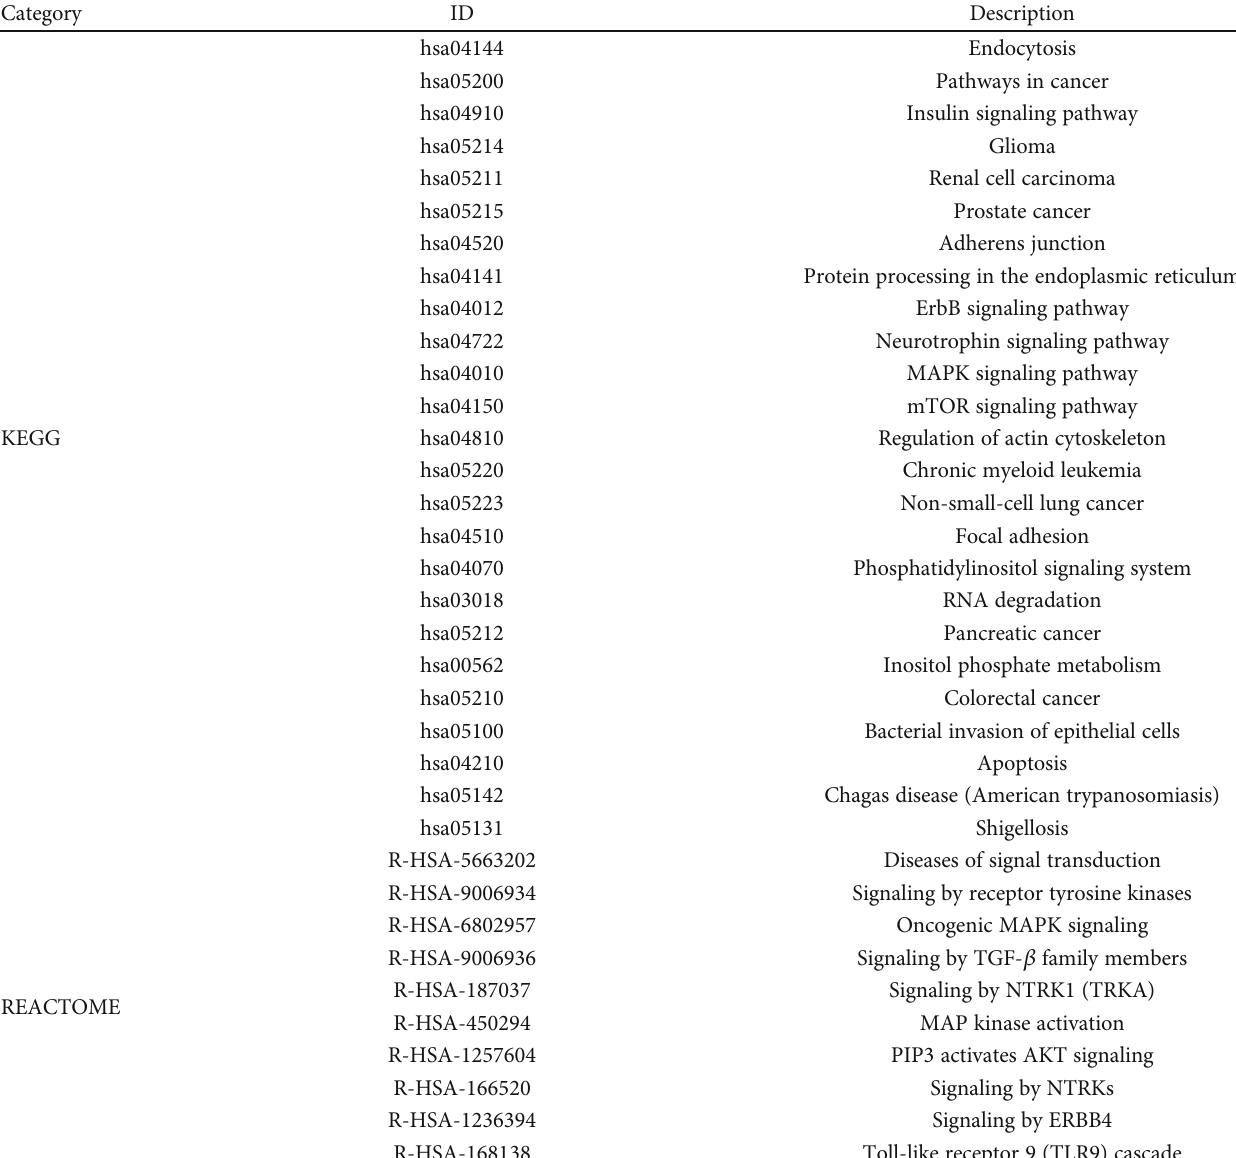
Table 1: Common pathways among target genes of the 3 di ff erentially expressed